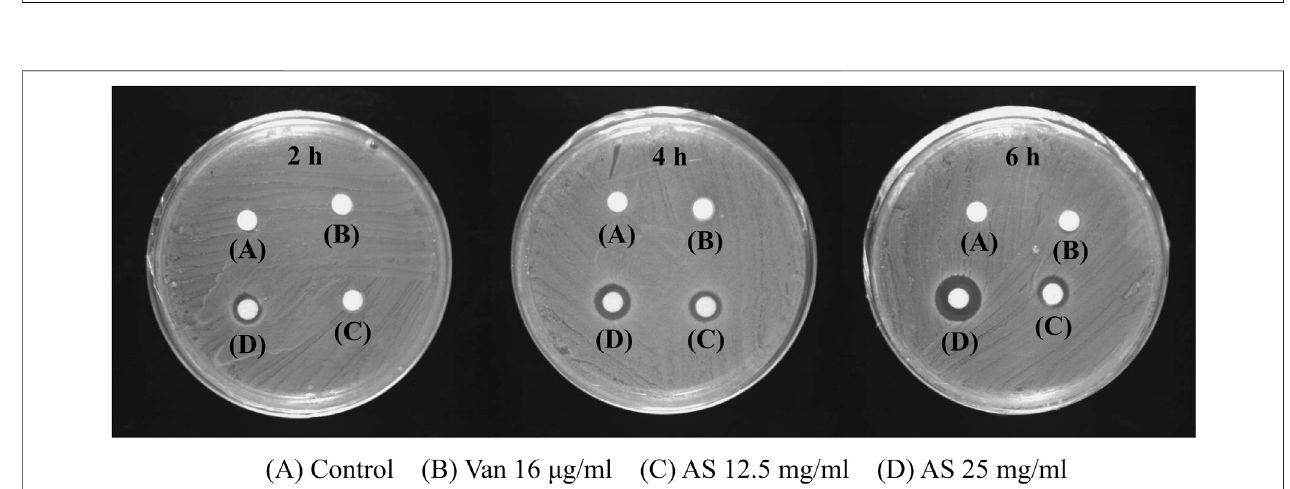
FIGURE4| EffectsofASandVanonthepermeabilityofMRSAbio fi lms.The16 μ g/mlVan-treatedgroupwasthesameascontrolgroupatallthreetimepointsand there was no inhibition zone. The 12.5 mg/ml AS showed inhibition zone at 4 h and 6 h, which was weak. The inhibition zone increased with an increasing duration of action of 25 mg/ml AS (6 h > 4 h > 2